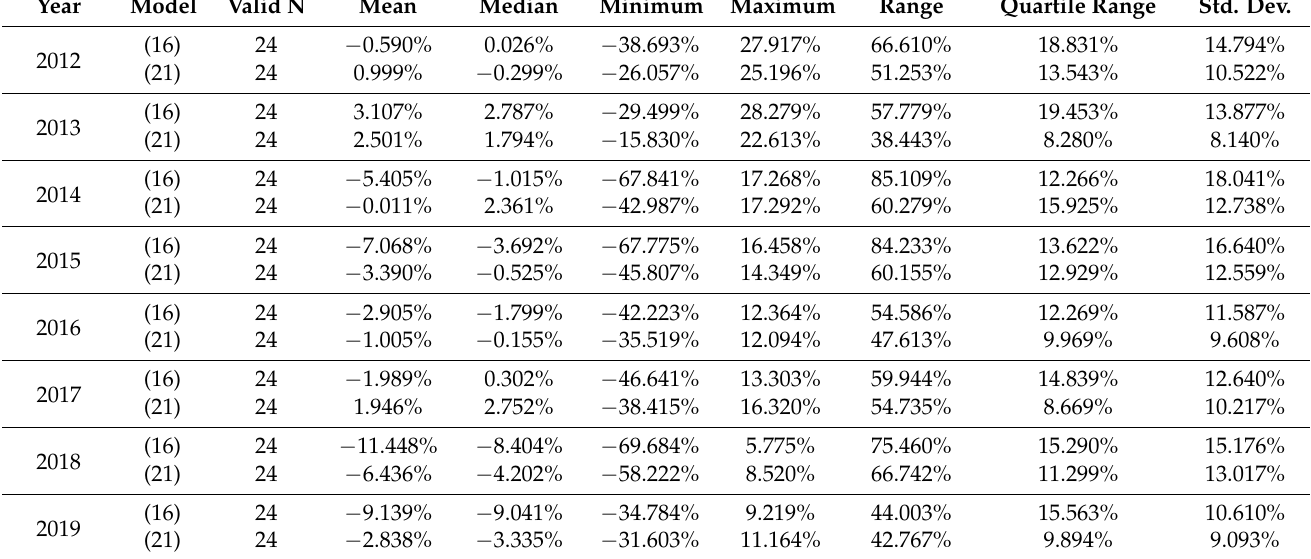
Table 7. Descriptive statistics of relative residuals of models (16) and (21) for monitored years.